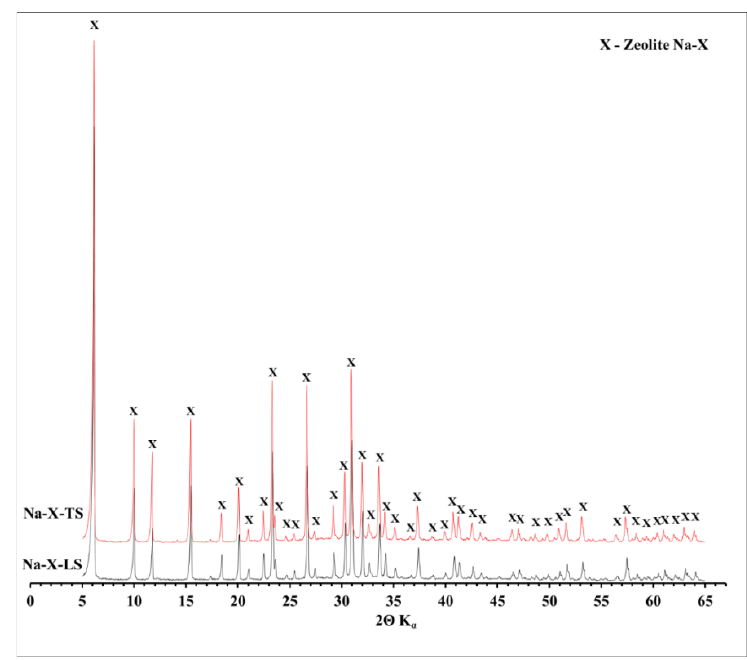
Figure 2. Mineral phase composition of Na-X-LS and Na-X-TS zeolites.